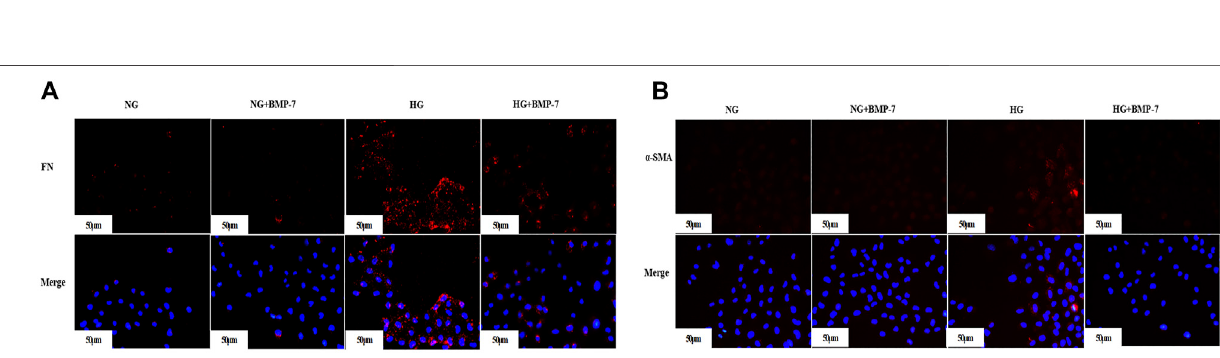
FIGURE 4 | Detection of fi brosis-related index levels after overexpression of BMP-7 in vivo . (A) Western blot was used to detect EMT and ECM related indexes in the normal control group, diabetes model group, and rAAV + BMP-7 group, * p < 0.05 vs. NC group, # p < 0.05 vs. DM group. (B) Immunohistochemistry was used to detecttheexpression ofFNintheparaf fi nsectionsofkidneytissueinthenormalcontrolgroup, thediabetesmodelgroup,andtherAAV+BMP-7group,andtheratioof the positivestainingarea tothe total tissue area under each fi eld wascounted. * p < 0.05 vs. NC group, # p < 0.05 vs. DM group (scale bar is100 μ m) (C) Real-time PCR was used to detect tissue FN RNA expression levels. * p < 0.05 vs. NC group, # p < 0.05 vs. DM group.